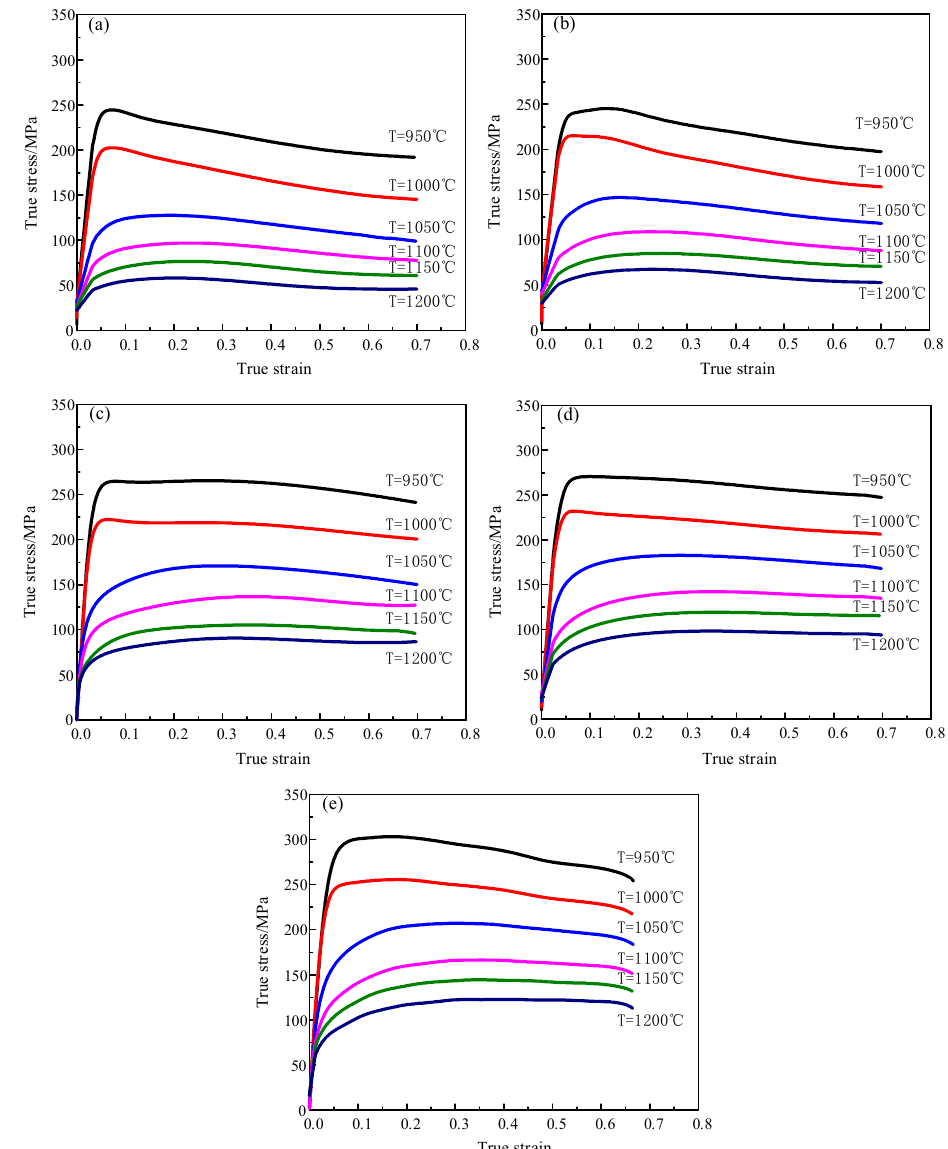
Figure 4. Curves of true stress–strain of X12CrMoWVNbN10-1-1 alloy at different deformation conditions: ( a ) ε = 0.05 s − 1 ; ( b ) ε = 0.1 s − 1 ; ( c ) ε = 0.5 s − 1 ; ( d ) ε = 1 s − 1 ; ( e ) ε = 5 s − 1 .